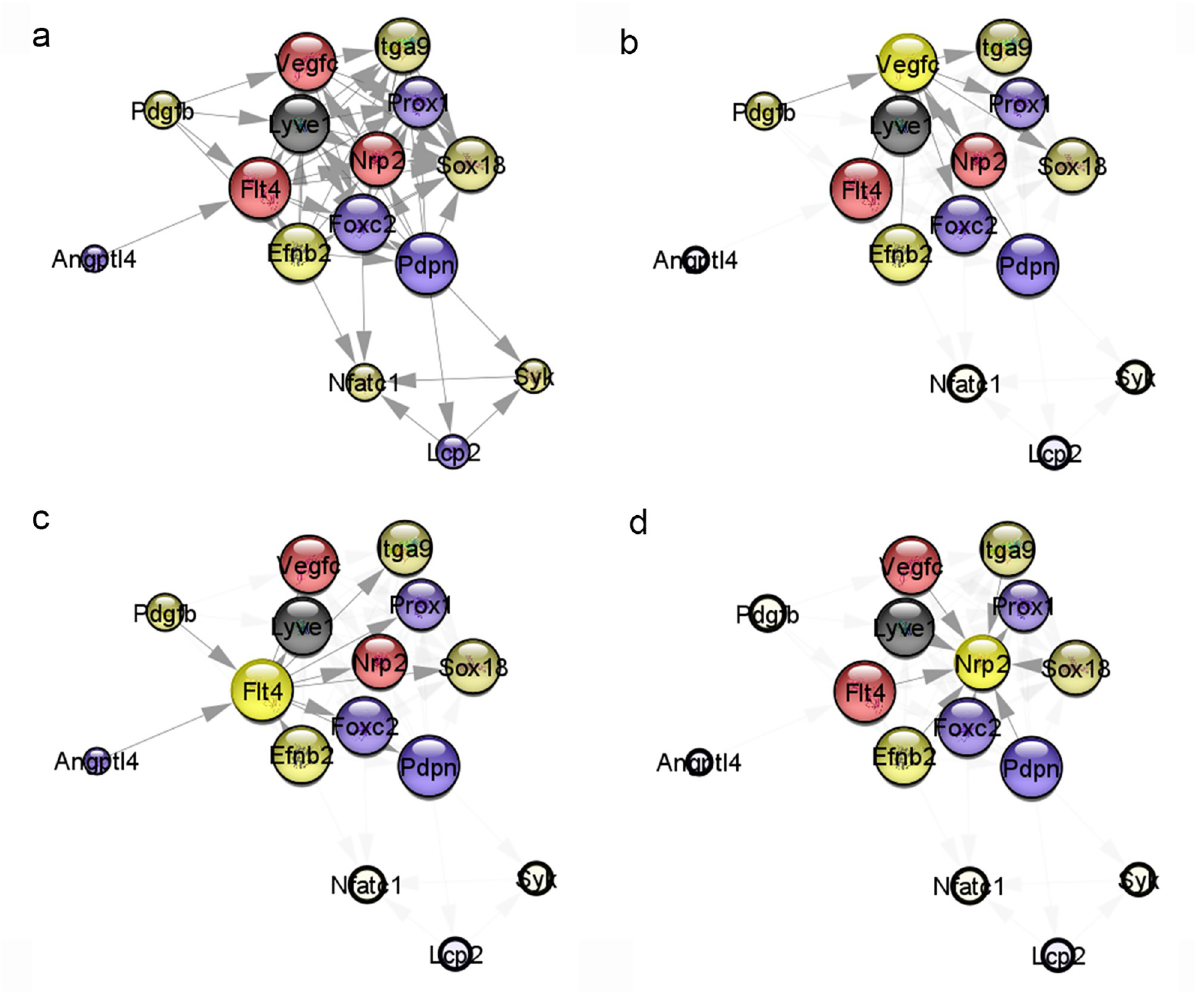
Fig 8. Lymphangiogenesis pathway gene of the protein–protein interaction (PPI) network obtained using Cytoscape with the Search Tool for the Retrieval of Interacting Genes (STRING) plug-in. (a) The PPI network for all lymphangiogenesis pathway genes is shown. The PPI network of genes regulating or regulated by (b) Vegfc , (c) Flt4 , and (d) Nrp2 . Near red color indicates upregulation, and near black color indicates downregulation; the larger the circle, the larger the value of interaction degree. ( n = 3 for each group).